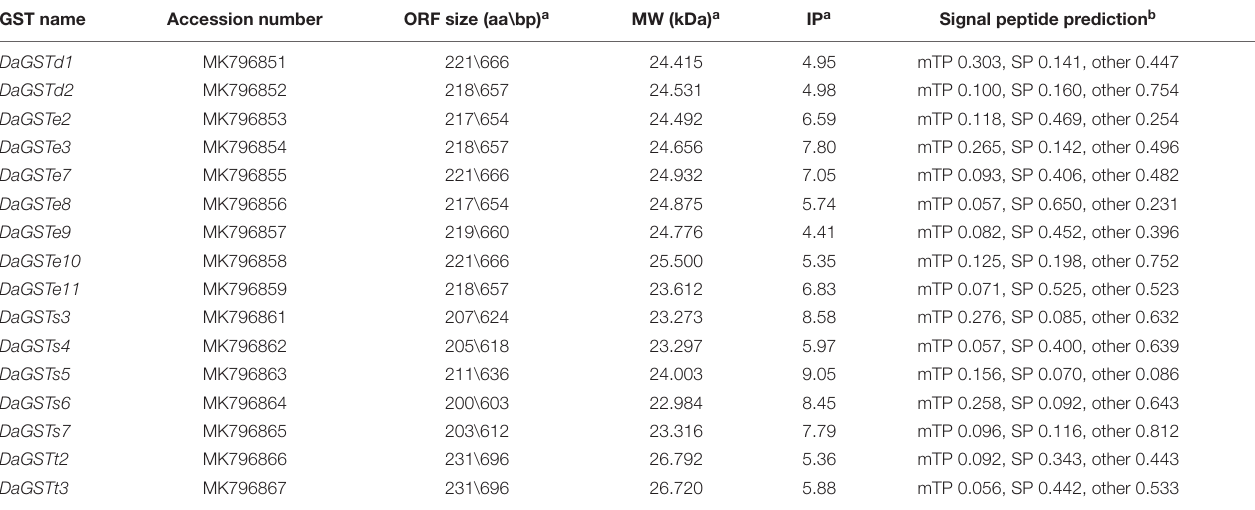
TABLE 1 | Physicochemical properties and cellular localization of putative Dendroctonus armandi GST